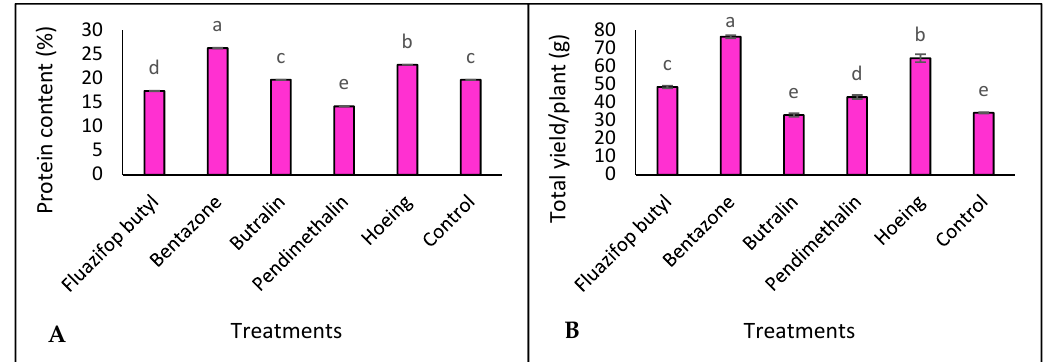
Figure 4. Effect of pre- and postemergence herbicides on protein content ( A ), yield/plant ( B ). Different letters indicate Scheme 0. vertical bars indicate standard error.